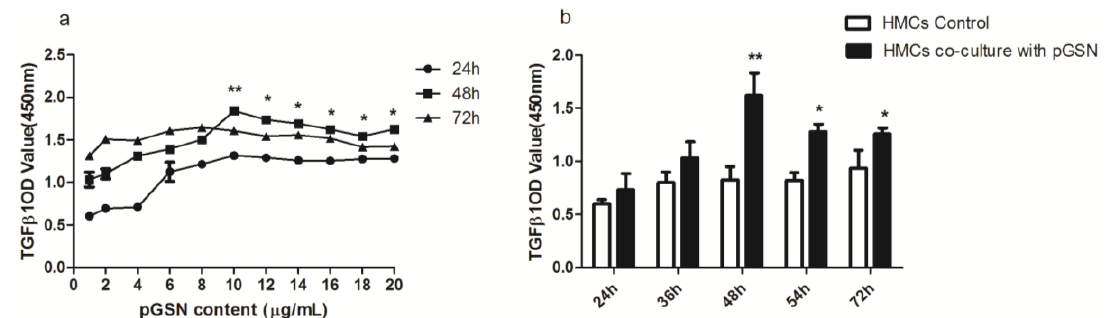
Figure 2. The testing result of TGF-β1 secretion by HMCs which stimulated with pGSN. ( a ) TGF-β1 had a peak secretion when HMCs were cultured with pGSN in 10 µg/mL for 48 h; ( b ) the TGF-β1 secretion by HMCs stimulated with or without pGSN, which showed that TGF-β1 secretion increased with 10 µg/mL pGSN for 36, 48, and 54 h (* p < 0.05), and the most obvious increased secretion was with HMCs stimulated for48 h (** p < 0.01). Each point in the ELISA experiment contains three repeated data ( n = 3), the between-group differences were calculated with one-way ANOVA and LSD tests, and the results are presented as means ± standard deviation (SD).